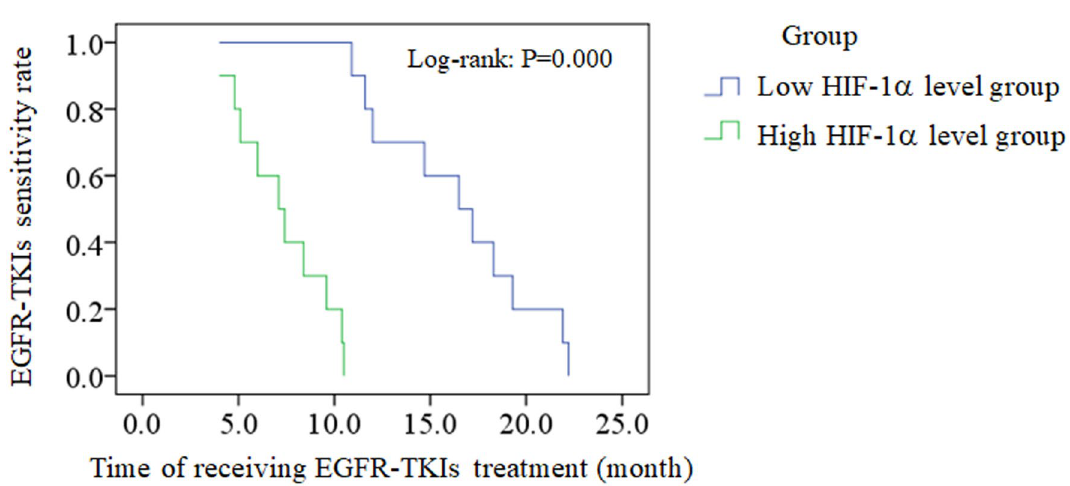
Figure 5. Kaplan–Meier analysis evaluated the EGFR-TKIs sensitivity rate of low HIF-1α level group and high HIF-1α level group in 30 months for 20 cases with acquired EGFR T790M mutation . 20 acquired EGFR T790M mutation patients were divided into low HIF-1α level group (n = 10, ≤ median) and high HIF-1α level group (n = 10, > median) according to the median level (median = 5.5) of HIF-1α before receiving treatment. Kaplan– Meier survival analysis was conducted. EGFR-TKIs acquired resistance happened in a much shorter time of high HIF-1α level group than that of low HIF-1α level group (log-rank: P = 0.000). Clinical